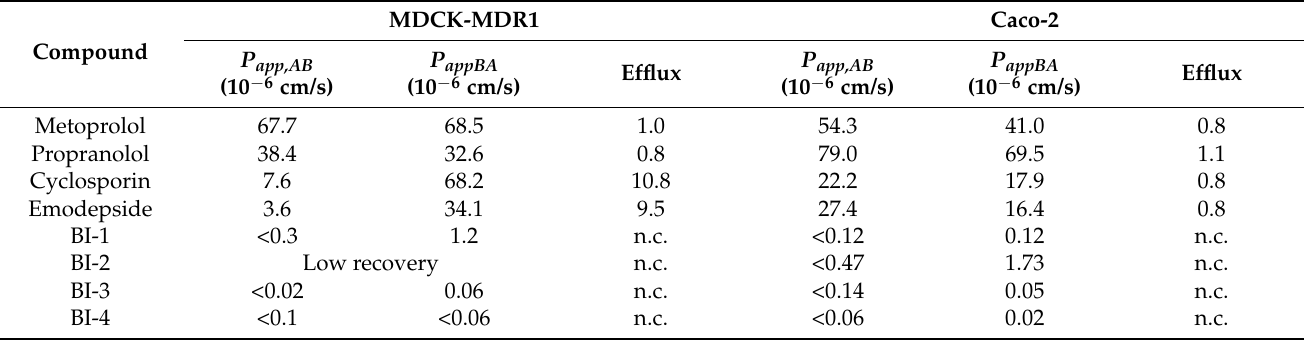
Table 2. Bidirectional permeability measured in MDCK-MDR1 cells and Caco-2 cells. Data are mean values of duplicates from standard permeability assays (see Section 2.3). Final concentration of compounds in donor compartment was 10 µ M. Highly permeable compounds metoprolol and propranolol are shown as